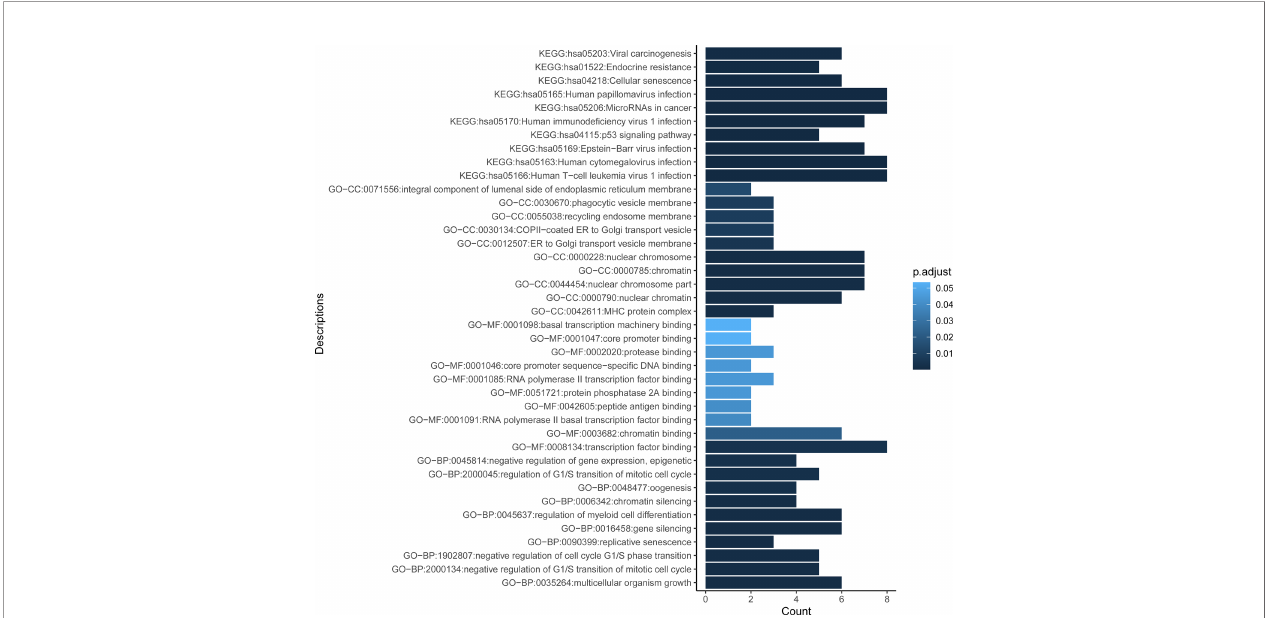
FIGURE 2 | Functional enrichment result reveals the top 10 function terms for GO and KEGG analysis. Gene Ontology (GO) comprises three categories: molecular function (MF), biological process (BP), and cellular component (CC). X axis represents the count of genes enriched in corresponding terms. Color depth of columns is positively related with the P value of term. KEGG, Kyoto Encyclopedia of Genes and Genomes.